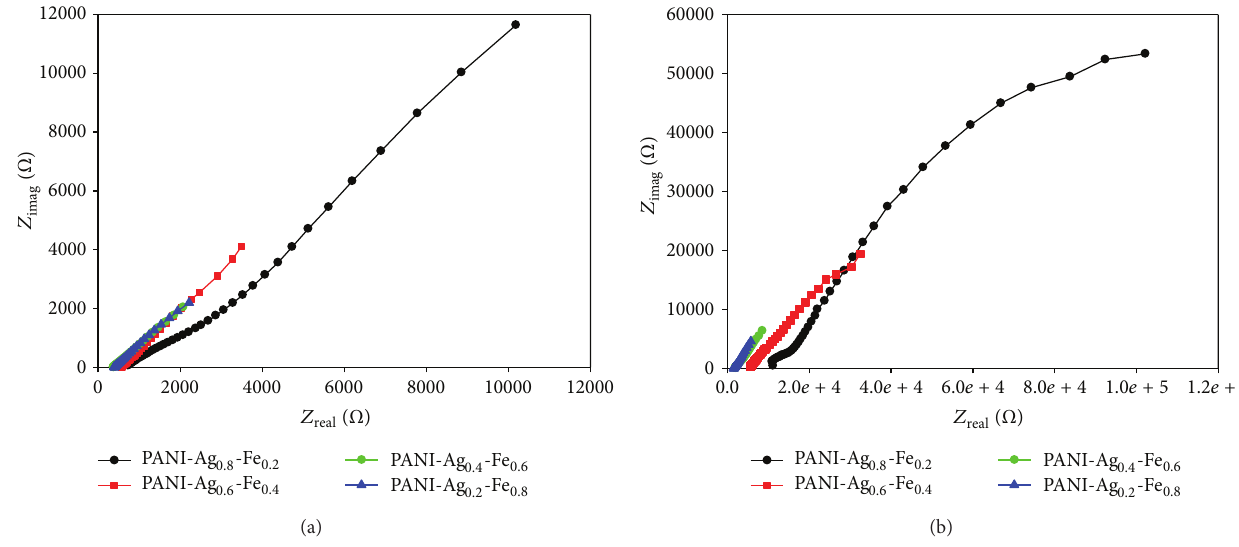
Figure 7: Nyquist impedance plot of PANI-Ag-Fe nanocomposite thin films microbial sensor (a) before annealing and (b) after annealing, when incubated in E. coli solution.